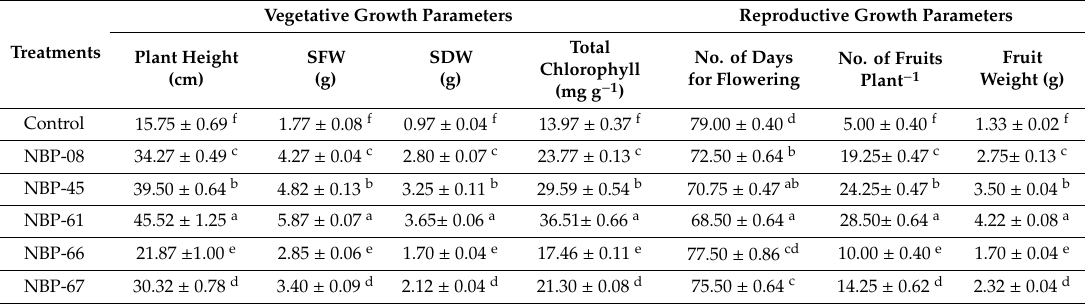
Table4. E ff ectofPGPFseedtreatmentonplantgrowthparametersofchilliundergreenhouseconditions.